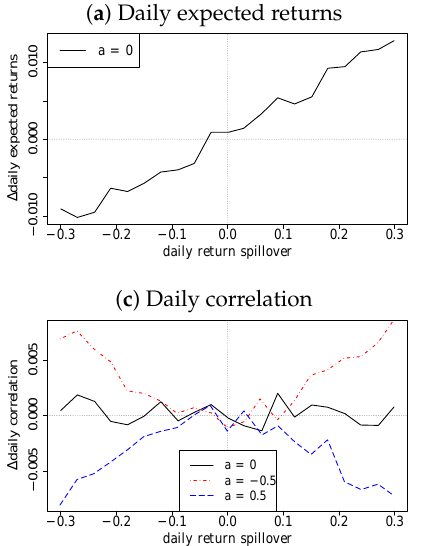
Figure 1. Effects of return spillovers on the same frequency assets’ characteristics. This figure presents the effects of daily return spillovers on expected returns ( a ), standard deviation of the spillover- receiving asset ( b ), and the return correlation between spillover-giving and spillover-receiving assets ( c ) at daily level. We use “daily” for the illustration purpose; the results apply to any other frequency. Because of overlaps between lines, we only present the case with a = 0 in ( a , b ). The graphs for a = − 0.5 and a = 0.5 are qualitatively